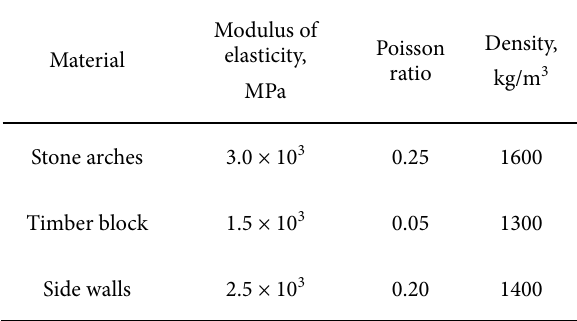
Table 1. Material properties considered in the analytical analysis